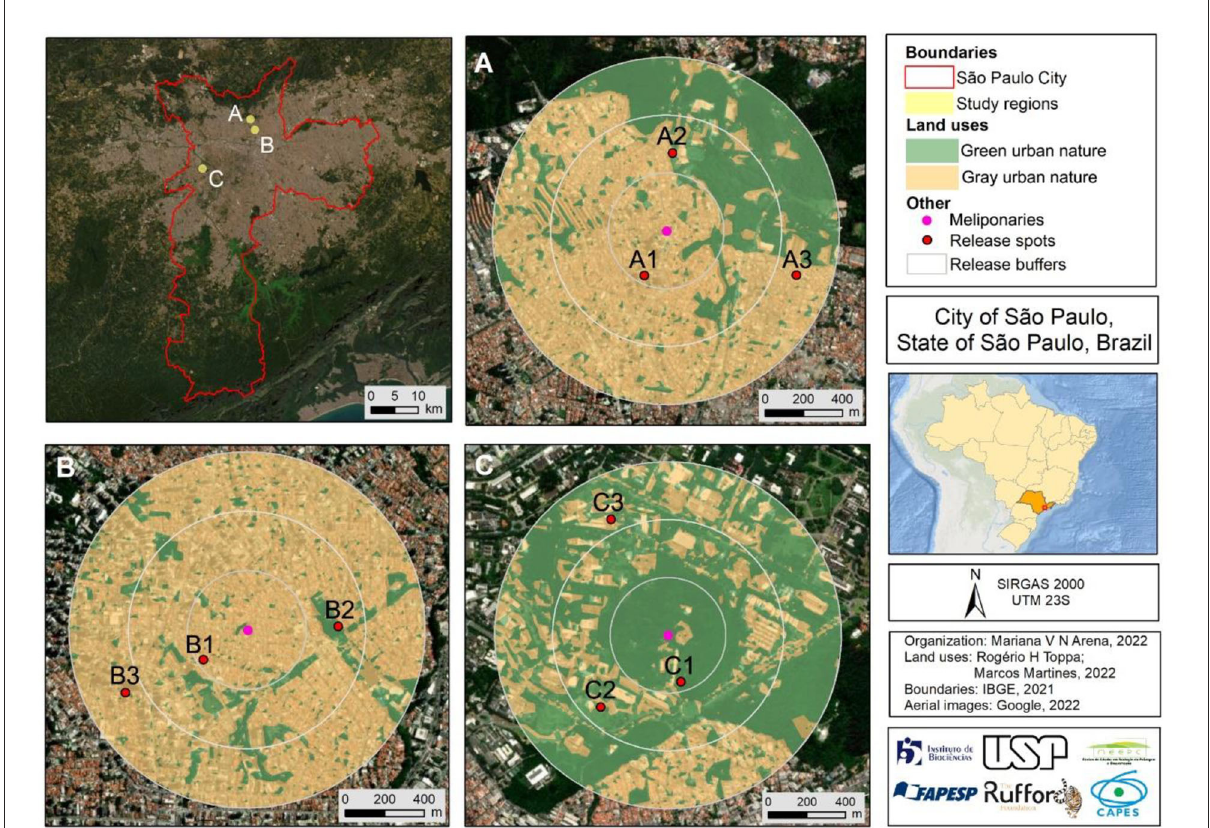
FIGURE1 Location of study areas (A–C) (meliponaries) in the city of São Paulo, state of São Paulo, Brazil, showing coverage regions, urban green and gray nature areas, and bees’ release spots and coverage regions.